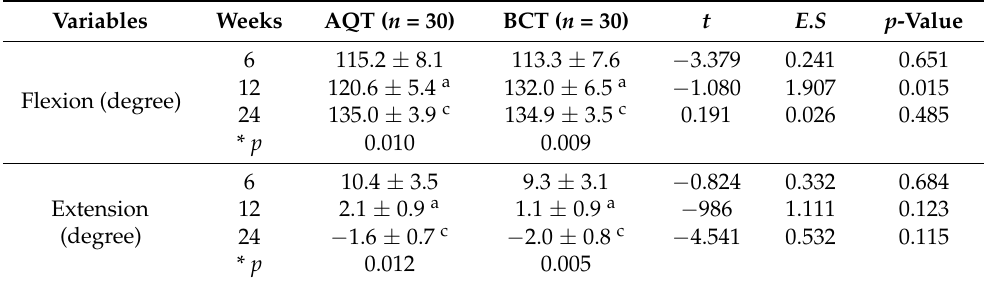
Table 4. Knee range of motion according to group and